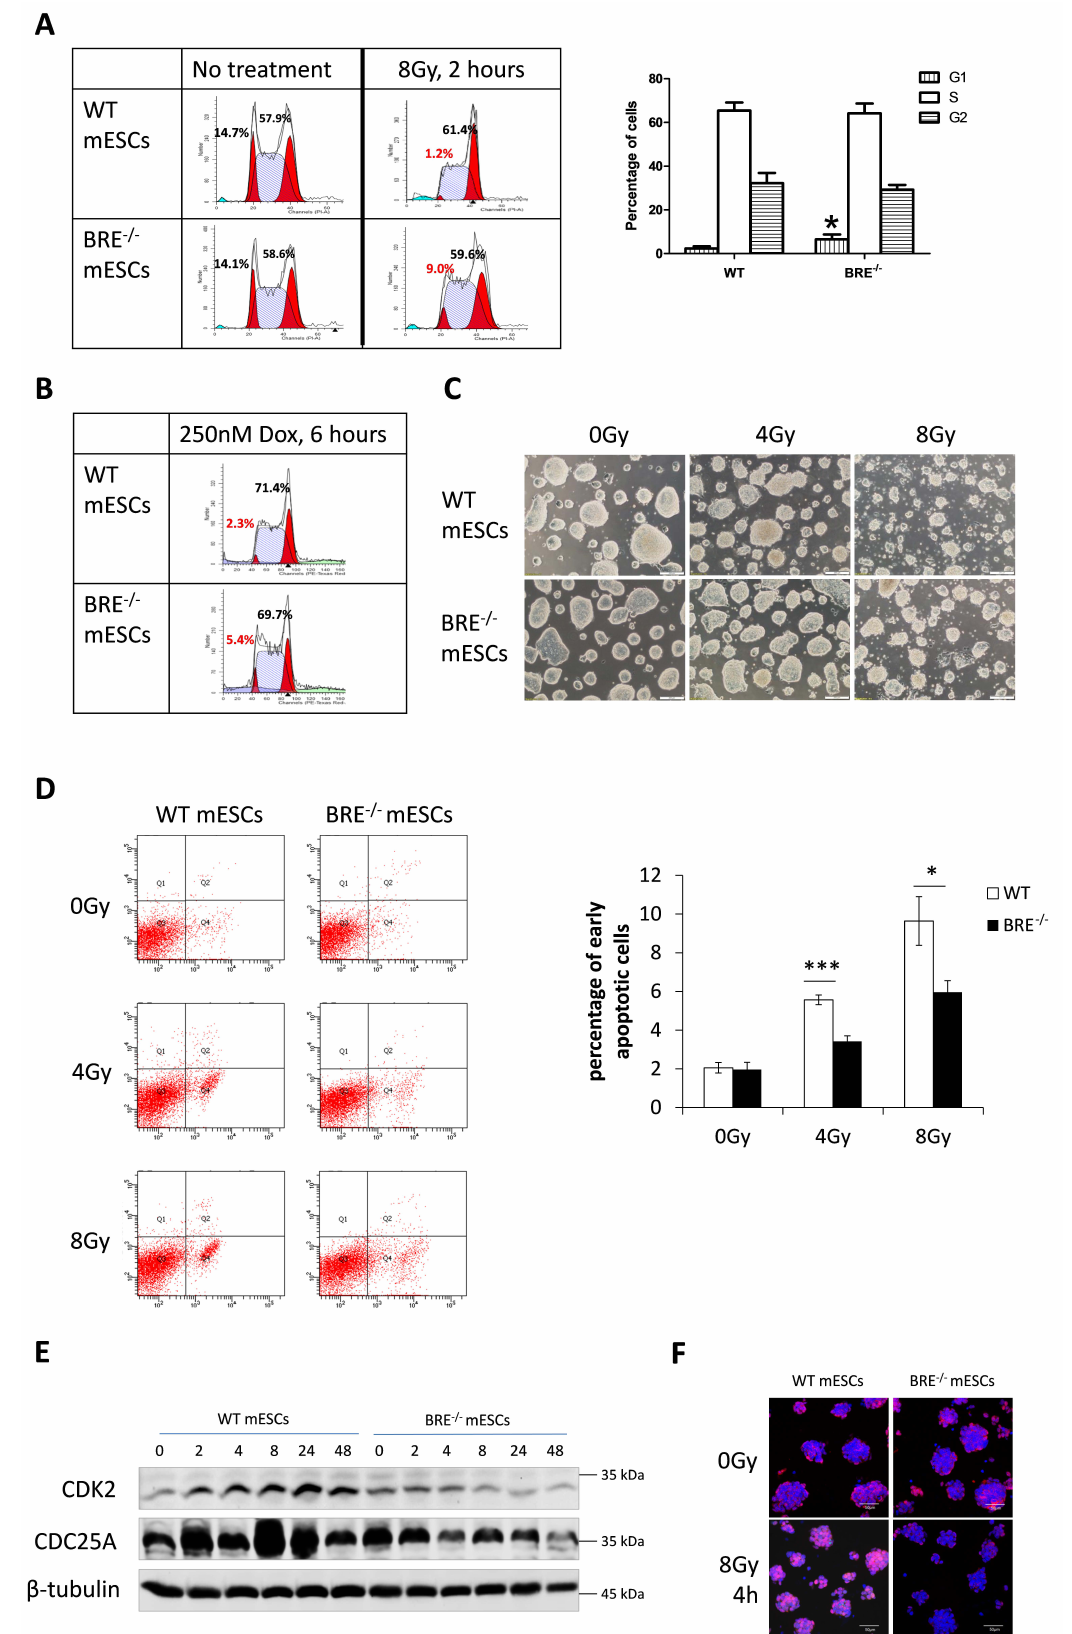
Figure 3. ProlongedG1phaseinBabam2 − / − mESCsaccompaniedbyattenuatedgammairradiation-induced apoptotic response. ( A ) Cell cycle distribution of WT and Babam2 − / − mESCs analyzed by flow